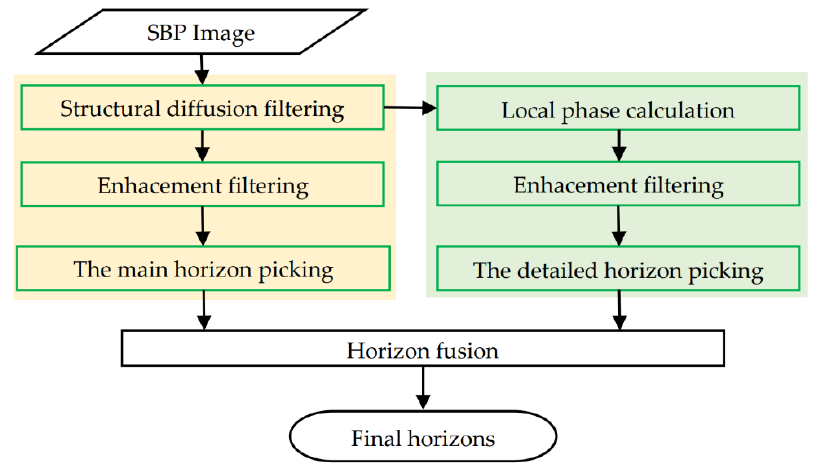
Figure 1. Flowchart of the horizon picking method.